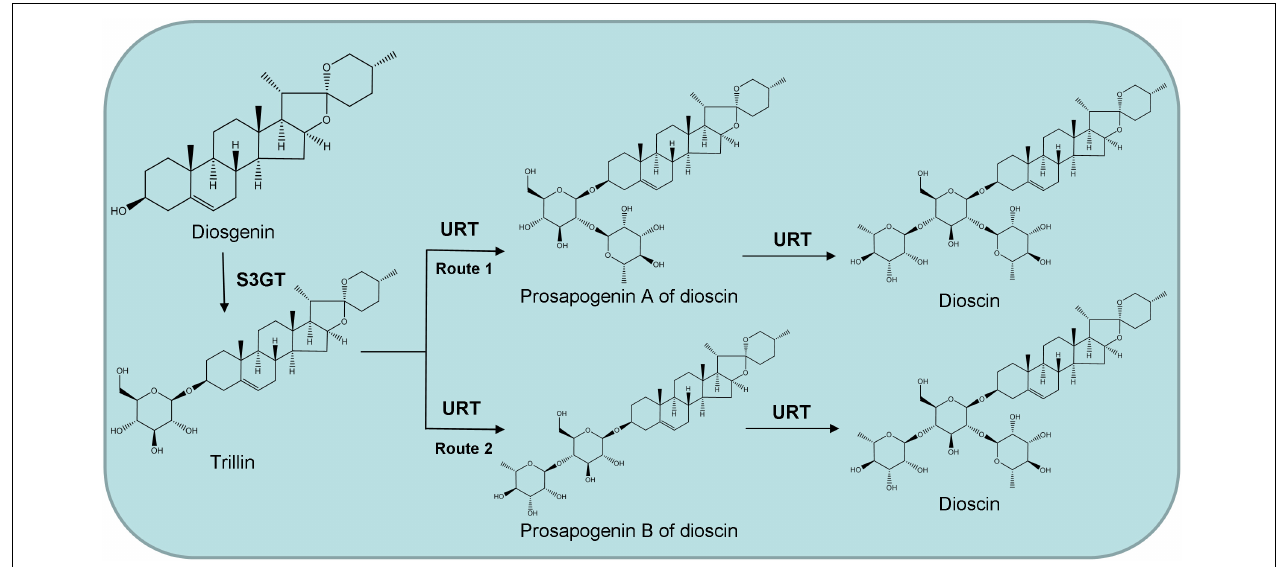
FIGURE 1 | Proposed two possible pathways for dioscin biosynthesis in Dioscorea zingiberensis . S3GT, sterol 3- O -glucosyltransferase; URT, UDP-rhamnosyltransferase.